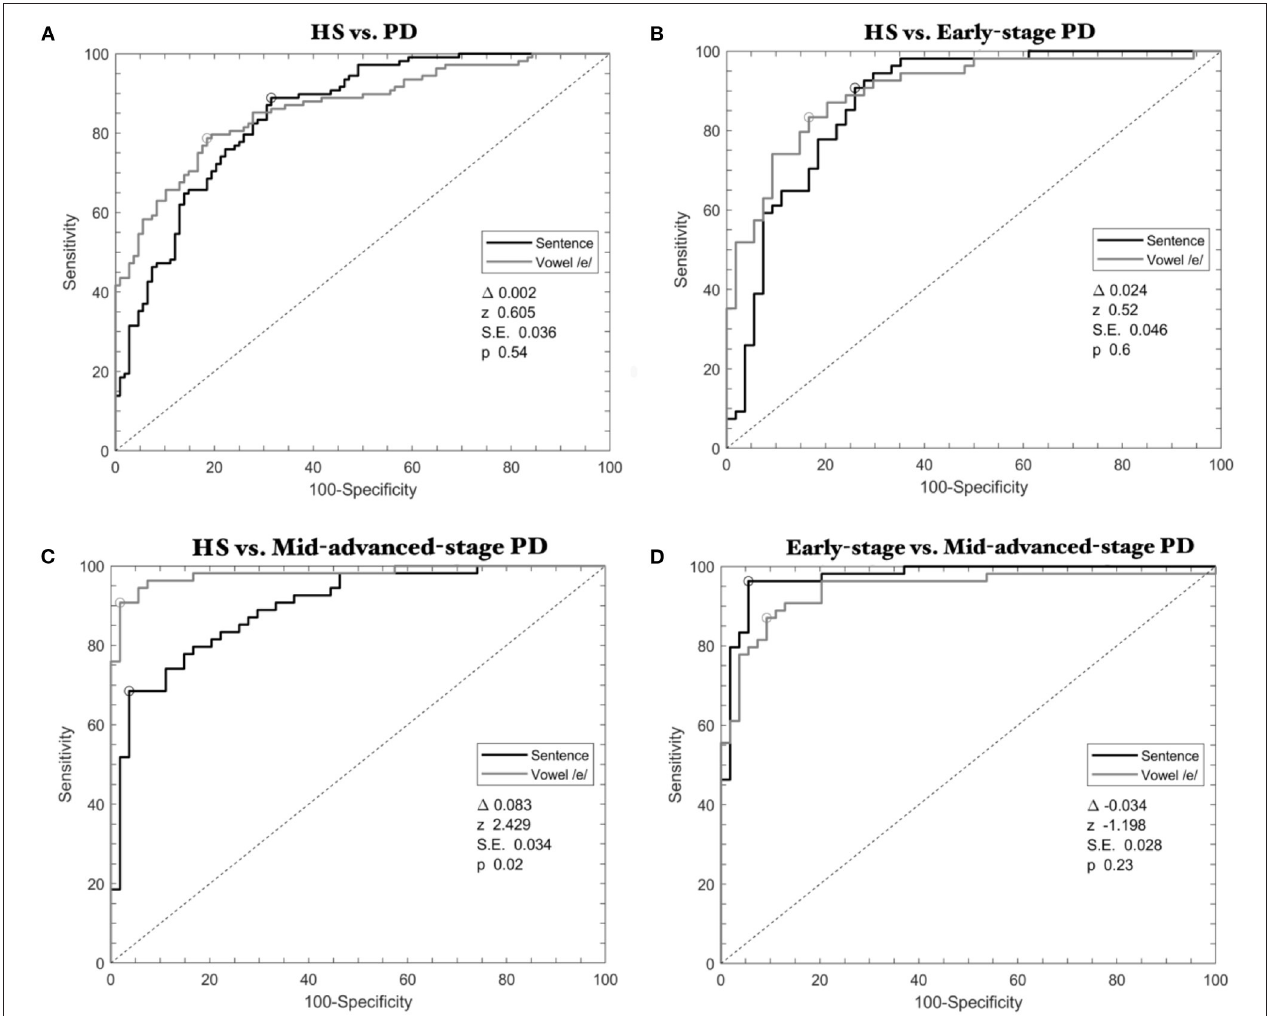
FIGURE 2 | ROC curves calculated through SVM classifier in Parkinson’s disease. (A) HS vs. the whole group of PD patients; (B) HS vs. early-stage patients; (C) HS vs. mid-advanced-stage patients OFF therapy; (D) Early-stage vs. mid-advanced-stage patients OFF therapy. Gray lines refer to the emission of the vowel, whereas black lines refer to the